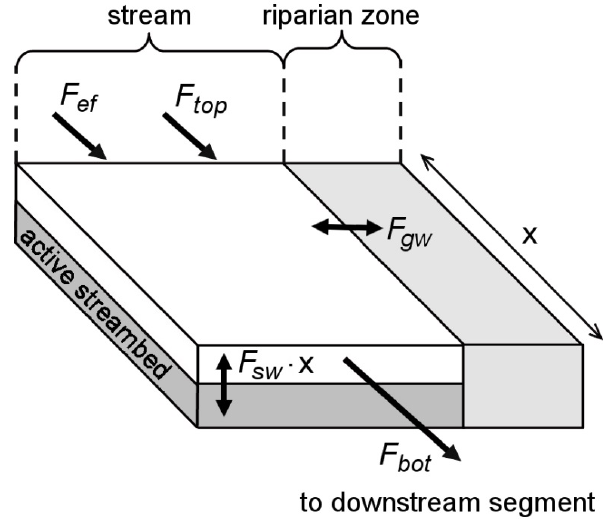
Figure 3. Conceptual representation of nutrient fluxes considered to estimate in-stream net nutrient uptake for each stream segment ( F sw × x , Eq. 2). For each segment of length x , the considered nu- trient input fluxes were upstream ( F top ) and tributaries ( F ef ). Nutri- ent fluxes exiting the stream segment ( F bot ) were F top for the con- tiguous downstream segment. Riparian groundwater nutrient fluxes could either enter ( F gw > 0) or exit ( F gw < 0) the stream. Nutrient fluxes for each component were estimated by multiplying its water flux ( Q ) by its nutrient concentration ( C ). In-stream net nutrient up- take ( F sw × x ) is the result of gross nutrient uptake and release by the active streambed. F sw × x can be positive (gross uptake > release), negative (gross uptake < release), or zero (gross uptake ∼ release). See text for